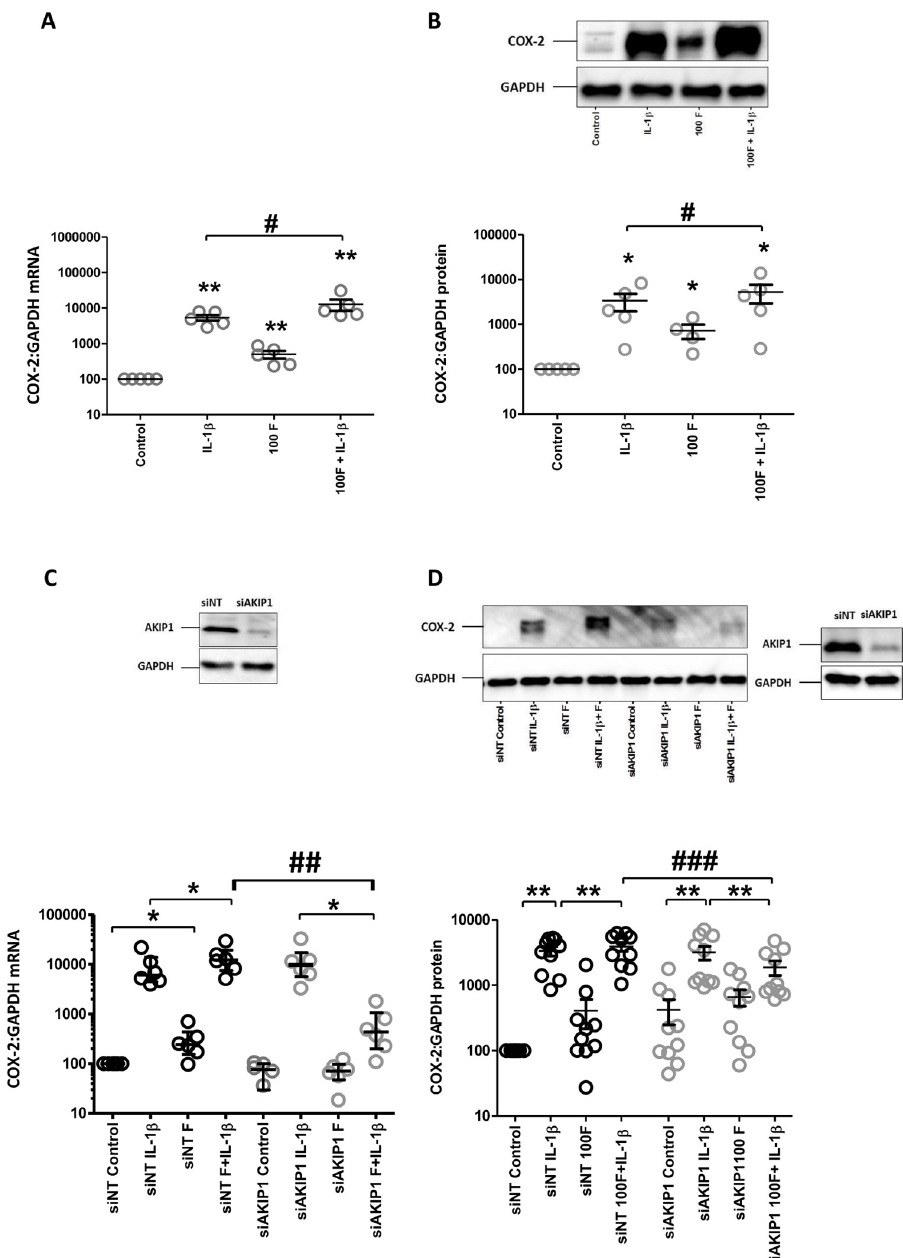
Fig 1. The effect of cAMP on IL-1 β -induced Cox-2 gene and protein expression, and the role of AKIP1. Myometrial cells were treated with IL-1 β (1ng/mL) and/or forskolin (100 μ M) either alone or in combination for 24h (A and B). AKIP1 protein expression was knocked down using siRNA (siAKIP1, controlled with non-targeted siRNA [siNT]). 96 hours after transfection the cells were treated with IL-1 β (1ng/mL) and/or forskolin (100 μ M) either alone or in combination for 6h (C and D). mRNA were extracted, and the levels of COX-2 mRNA expression were measured using quantitative rt-PCR (A and C). Proteins were extracted, and the levels of COX-2 protein expression were measured using western (B and D). A representative western blot to demonstrate transfection efficiency is shown on D. Data are shown as the mean and SEM, and analyzed as described in Materials and Methods ( � P < 0.05, �� P < 0.01, ��� P < 0.001 when compared to control; #P < 0.05, ##P < 0.01, ###P < 0.001 when IL-1 β is compared to 100F + IL-1 β ), n = 7–12.